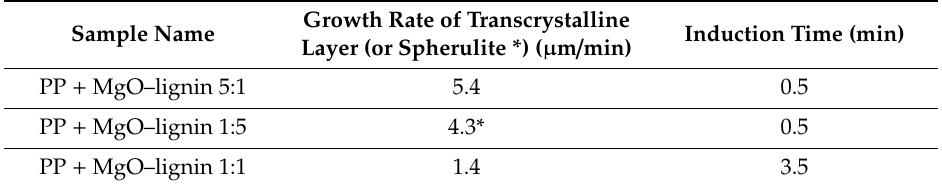
Figure 7. Crystallization of PP and its composites with ( a ) MgO–lignin 5:1 ( b ) MgO–lignin 1:5 ( c ) MgO–lignin 1:1 at 136 °C, at different times. Table 6. Growth rate and induction times of PP and its composites calculated from polarized light microscopy (PLM).